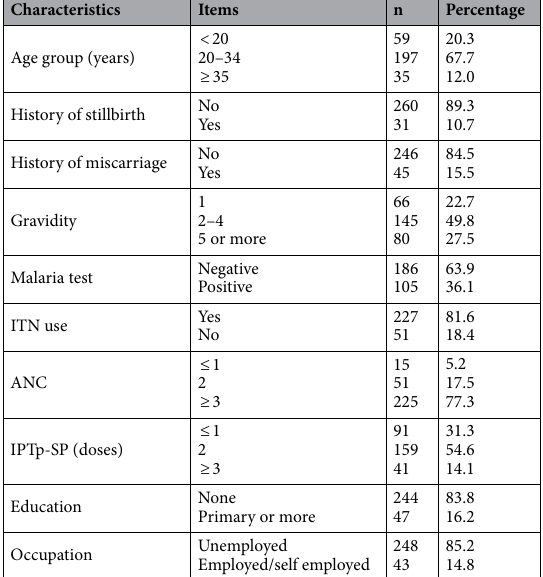
Table 2. Background characteristics of women included in the study (n = 291). ANC antenatal care, SP sulfadoxine-pyrimethamine, n the absolute number of observations for variables.